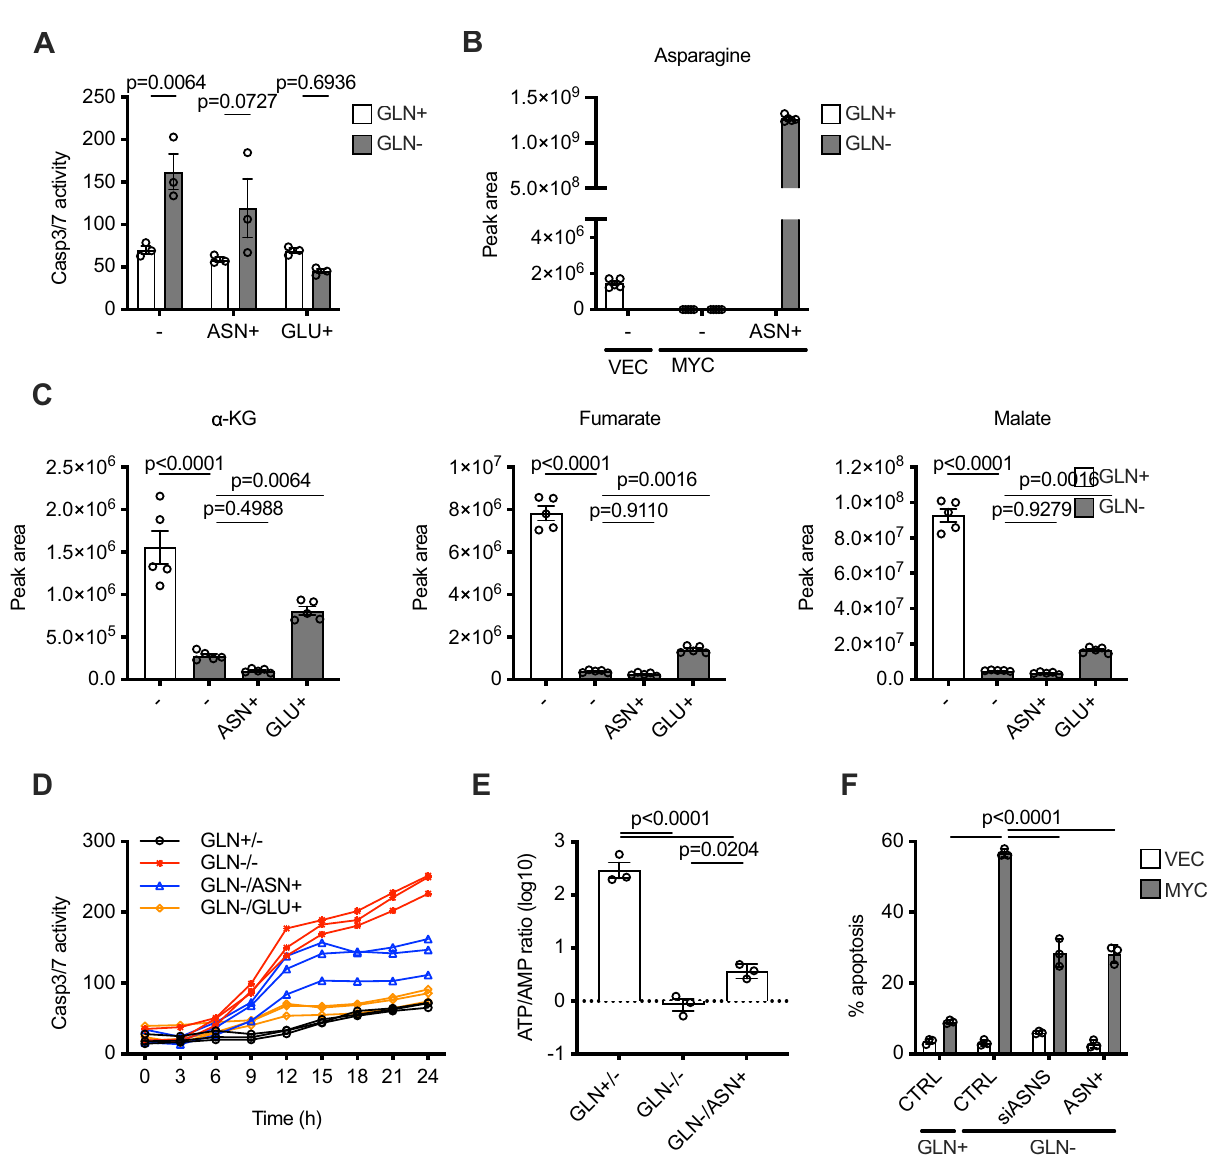
Fig. 6 | Glutamine withdrawal-induced apoptosis does not occur due to loss of asparagine.A IncucyteCaspase3/7apoptosisassay24haftertreatmentsshownin 4-OHT-treated BJ fi broblasts expressing MYC-ER T2 . Supplemented amino acids are at4mM.Anordinaryone-wayANOVAwasusedtodeterminestatisticalsigni fi cance ( n =3 biological replicates). B Peak area of asparagine 6h after glutamine with- drawal and asparagine supplementationin cellsas in( A ). C Peakareasof indicated metabolites 6h after glutamine withdrawal and amino acid supplementation in